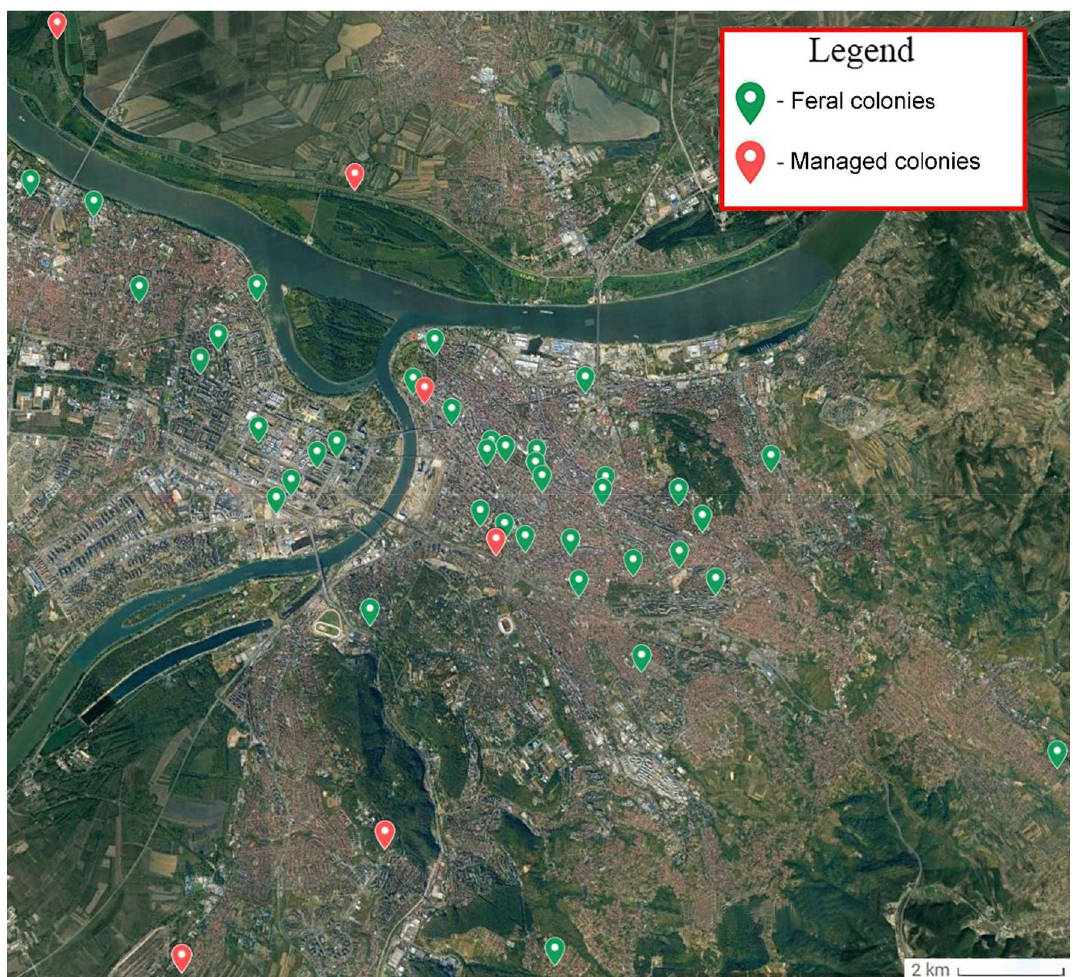
Figure 6. Sampling locations for feral and managed honey bee colonies in Belgrade. The base satellite imagery was obtained from Google Earth, and Adobe Photoshop CC 2015 (https:// www. adobe. com/ produ cts/ photo shop. html) was used to map the data by S. D. The locations overlying the map were obtained from the field using a GPS device (model no: Garmin eTrex